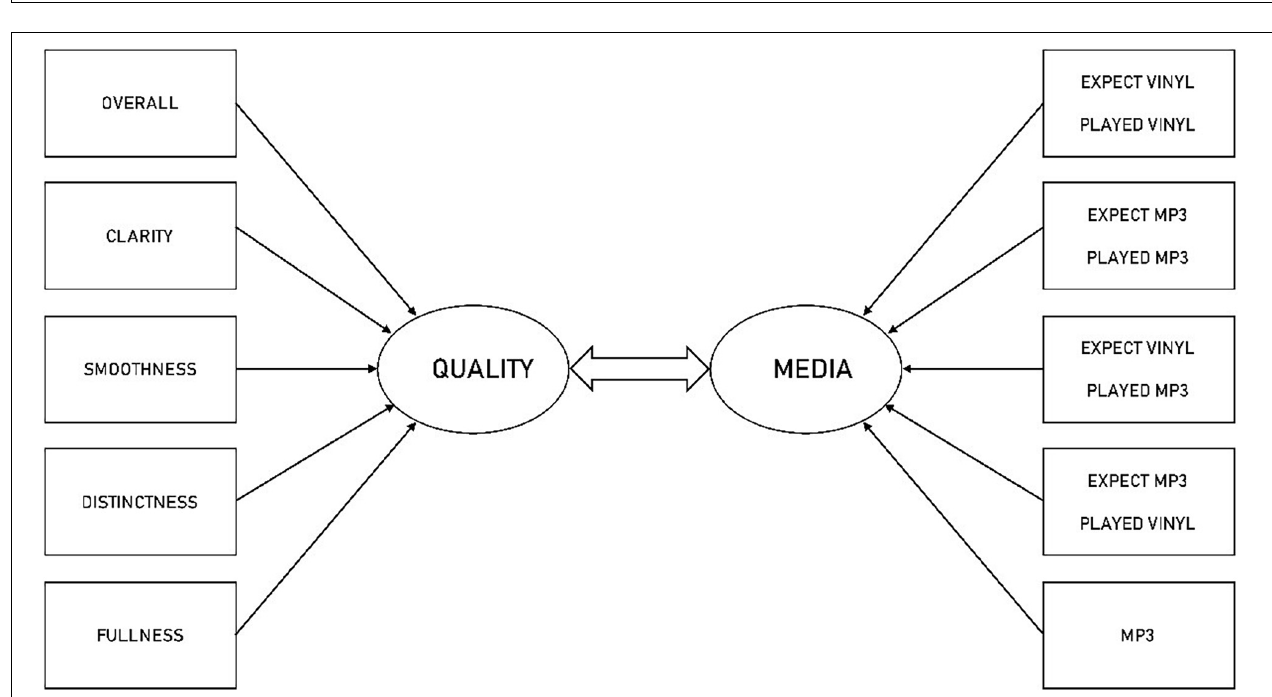
FIGURE 2 | Canonical Correlation model of the relationship between the experimental conditions and the dependent sound quality